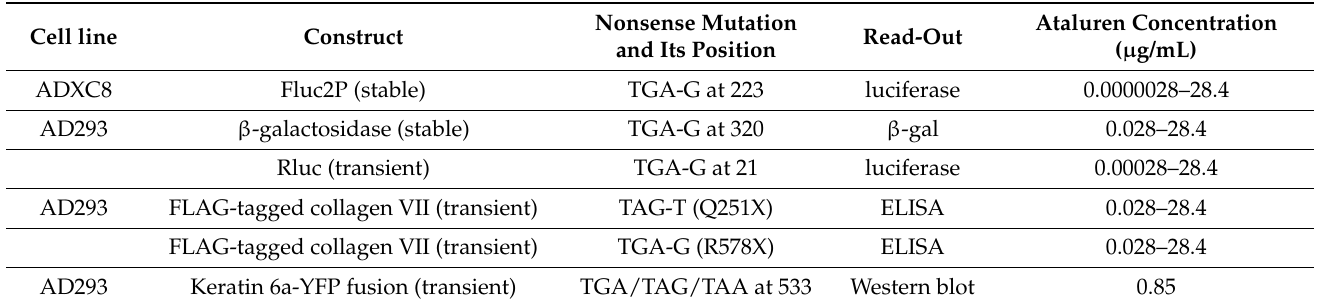
Table 2. The summary of cell-based reporter assays used to test ataluren readthrough